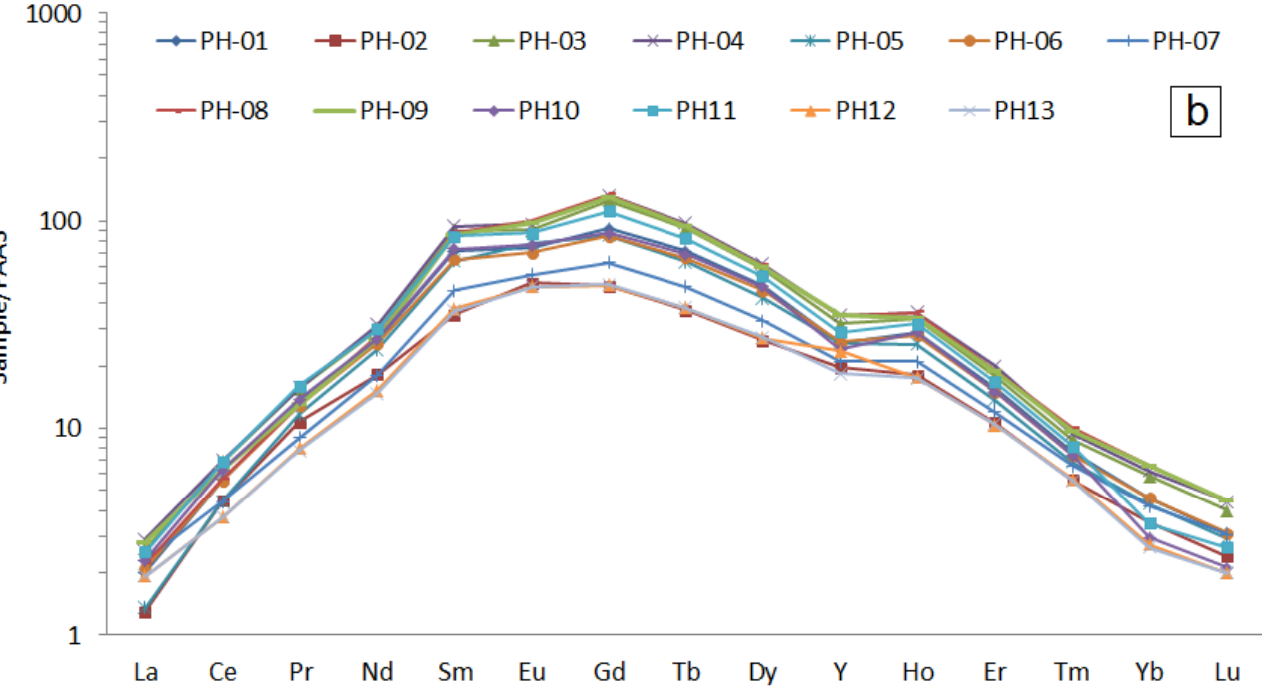
Figure 6. PAAS-normalized trace element ( a ) and REE ( b ) patterns of the phosphate nodules [60]. The Th/U ratios in the studied phosphate samples varied from 0.2 to 2.1. The Ni/Co ratios varied from 1.3 to 10.5. The V/Sc and V/Cr ratios were 4.97 (3 to 9) and 0.49 (0.31 to 0.75), respectively (Tables 3 and 4). The oxic/suboxic relationship between redox